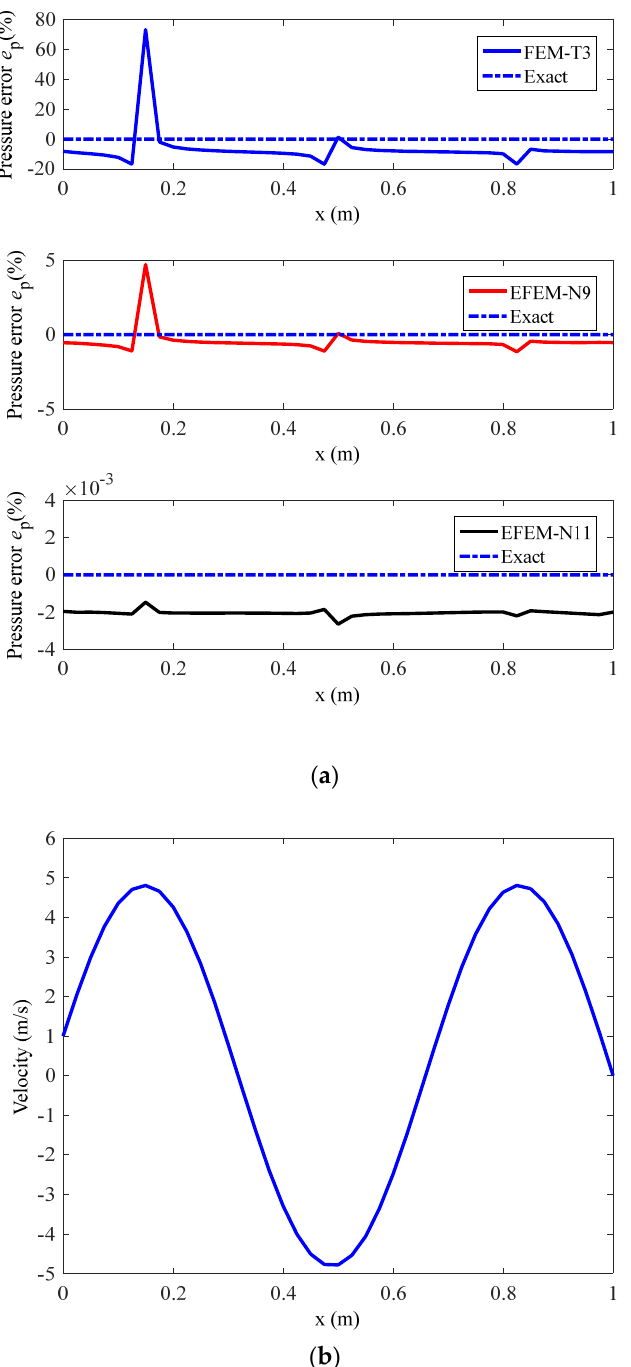
Figure 6. The calculated relative error results from different numerical techniques for the frequency value f = 2200 Hz: ( a ) the relative error results and ( b ) the corresponding exact acoustic particle velocity distributions.